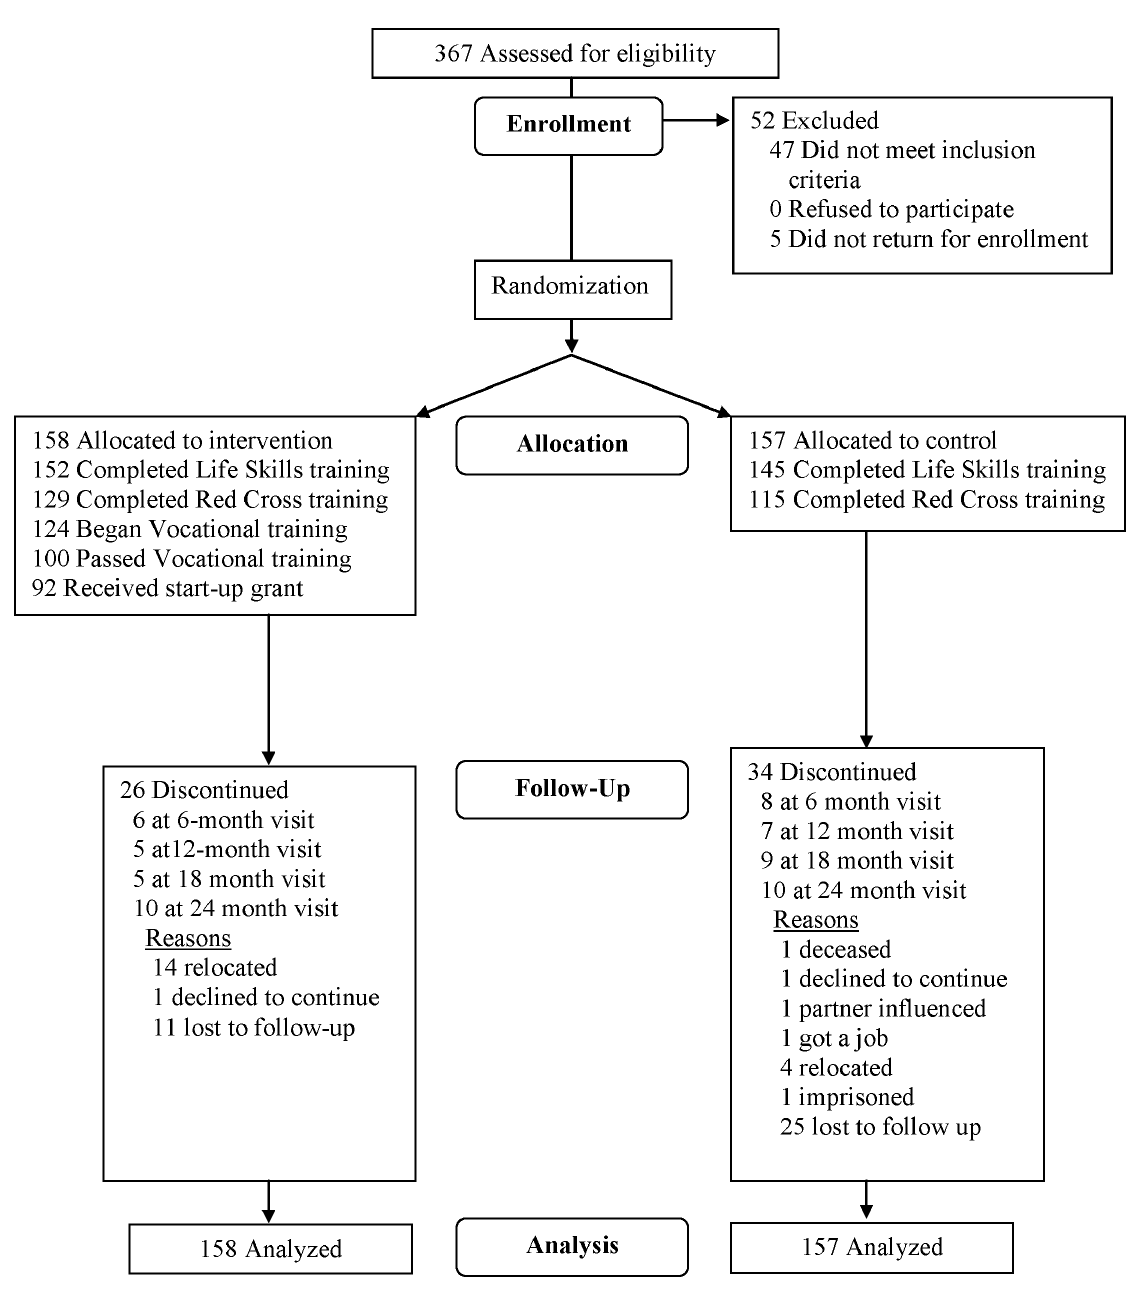
Figure 2. SHAZ! Study flow